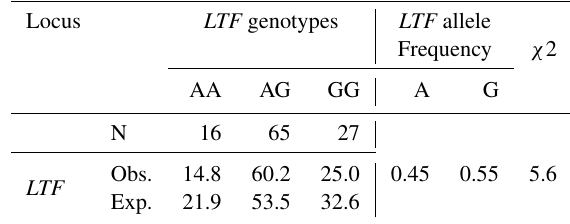
Table 1. The genetic and allelic frequencies of LTF-Eag I in don-